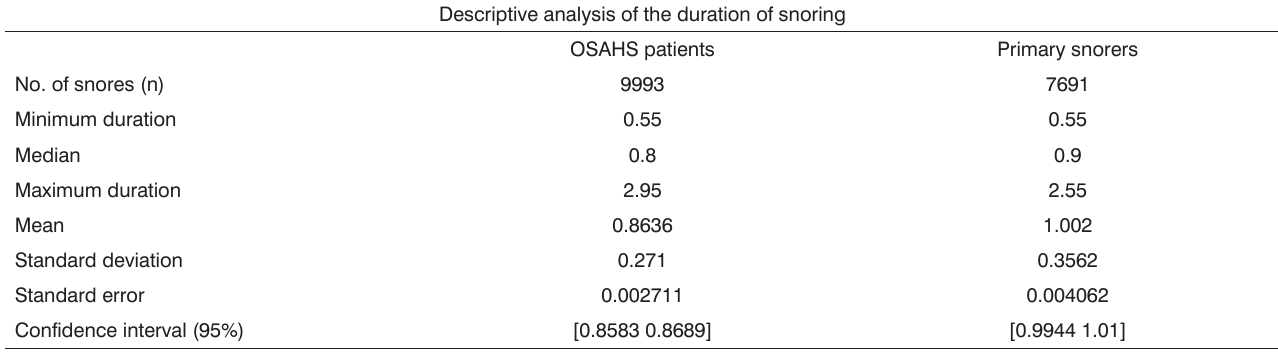
Table 3. Analysis of the duration, in seconds, of snoring